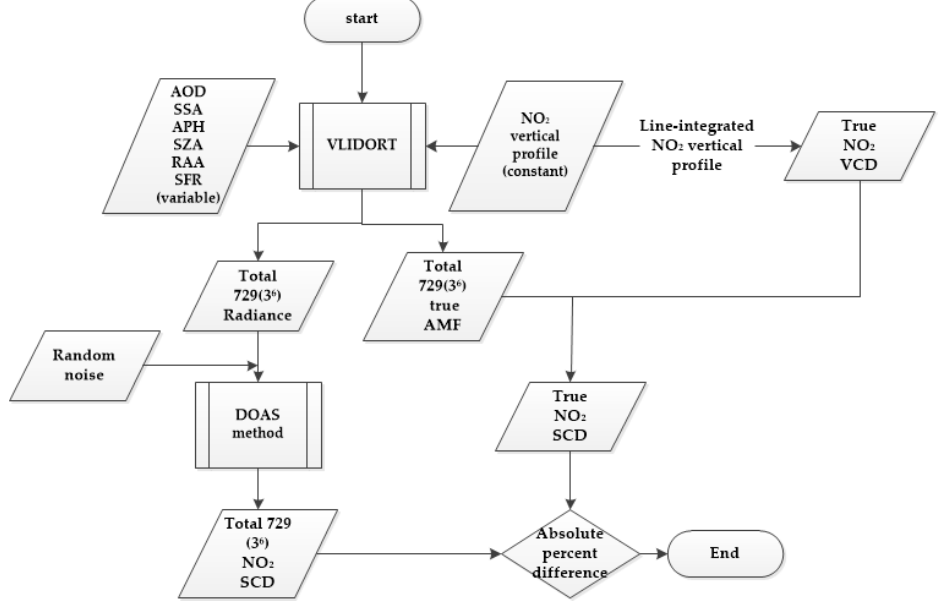
Figure 1. Flow chart of synthetic radiance and true air mass factor calculation.